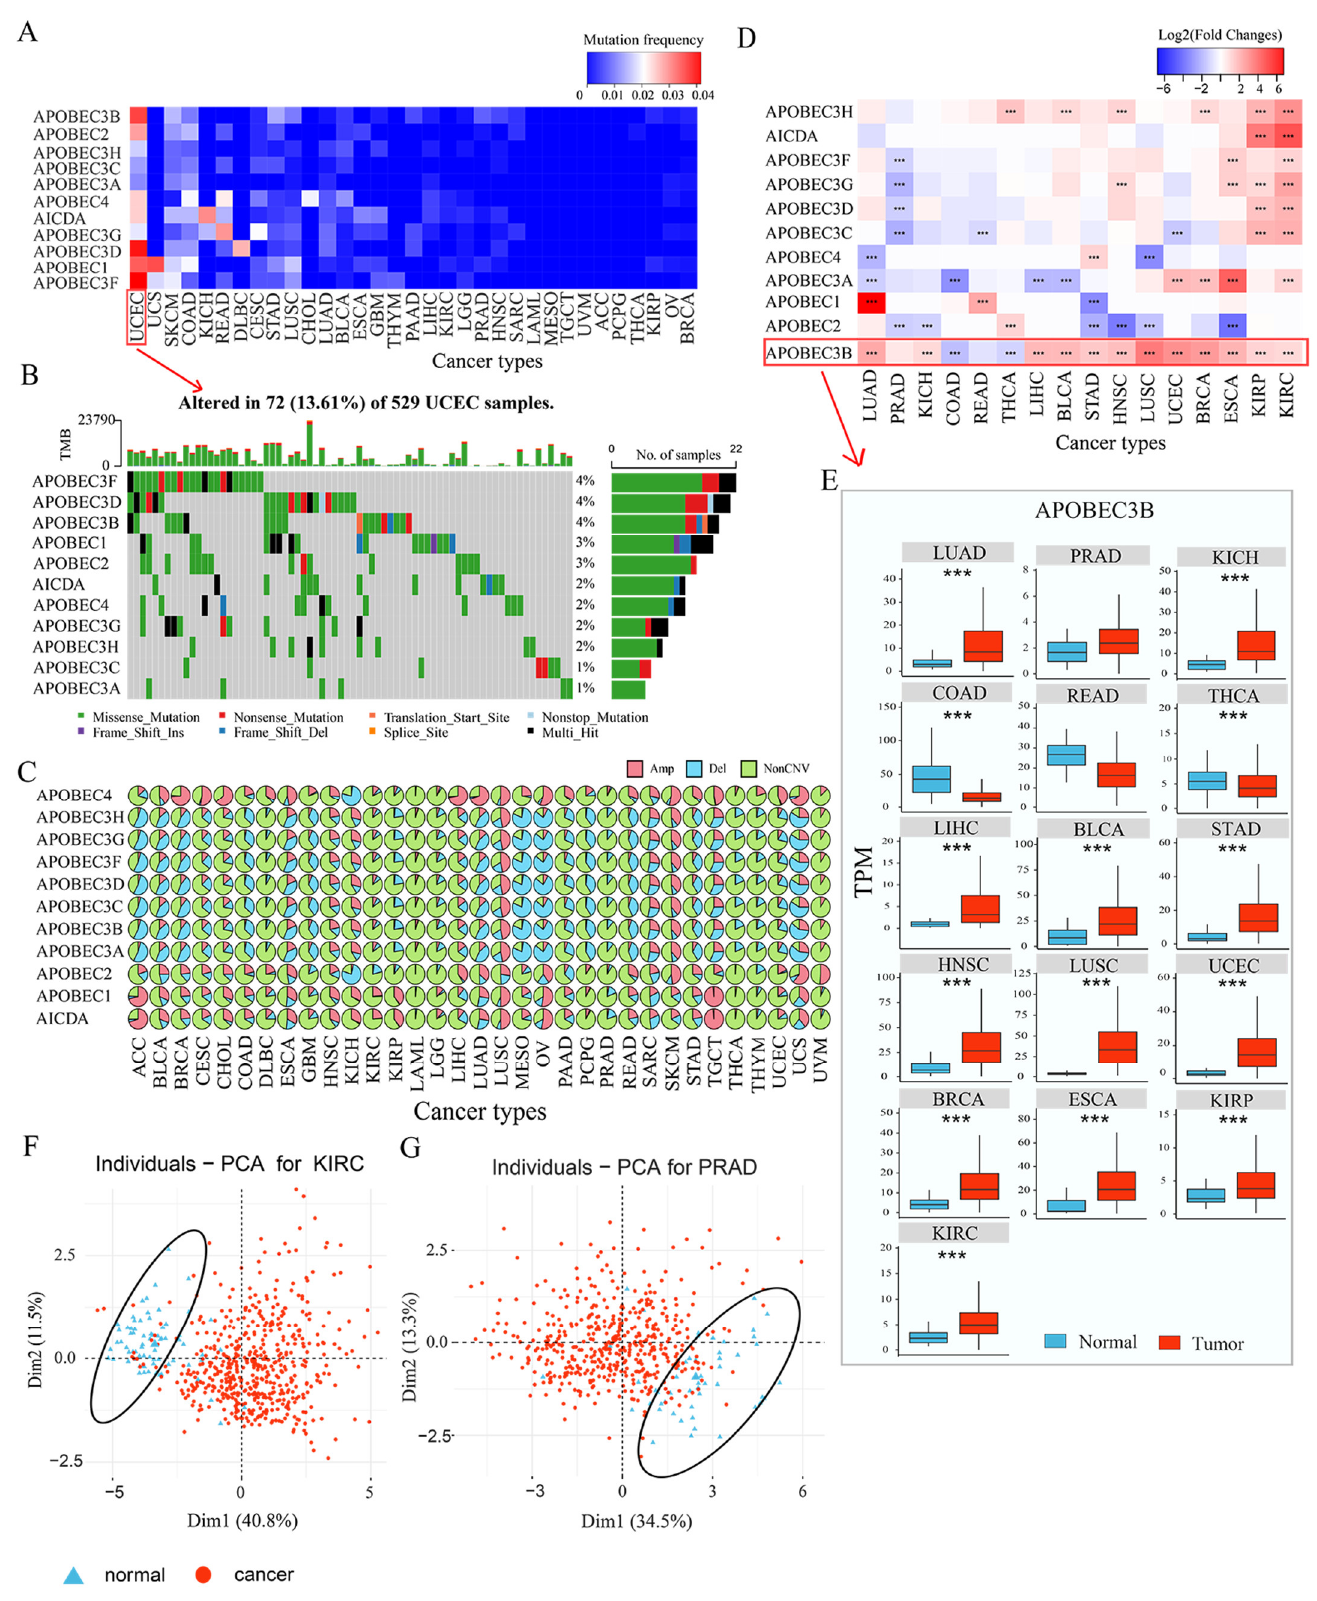
Figure 1. Pan-cancer genetic and expression alterations of APOBEC family. ( A ) The mutation frequency of 11 APOBEC genes across 33 cancer types; ( B ) The mutation frequency of 11 APOBEC genes in 529 UCEC samples. Each column represents individual samples. The upper bar graph shows TMB; the number on the right indicates the mutation frequency in each APOBEC gene. The right